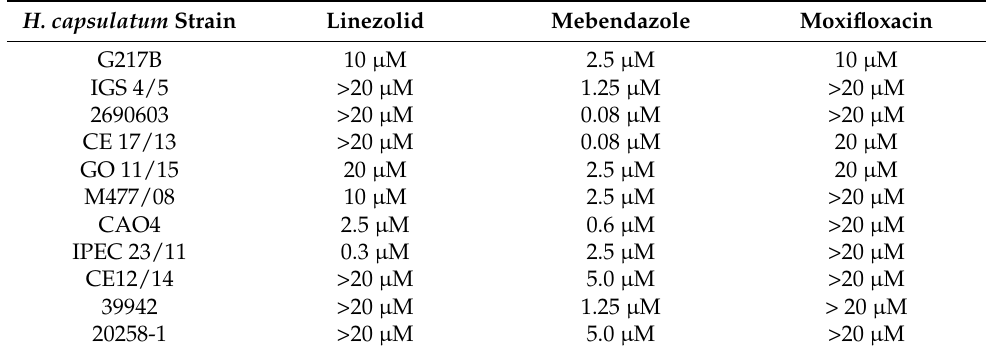
Table 1. Minimal inhibitory concentrations (consistent results from three independent experiments) of three antimicrobial drugs with anti- H. capsulatum activity.